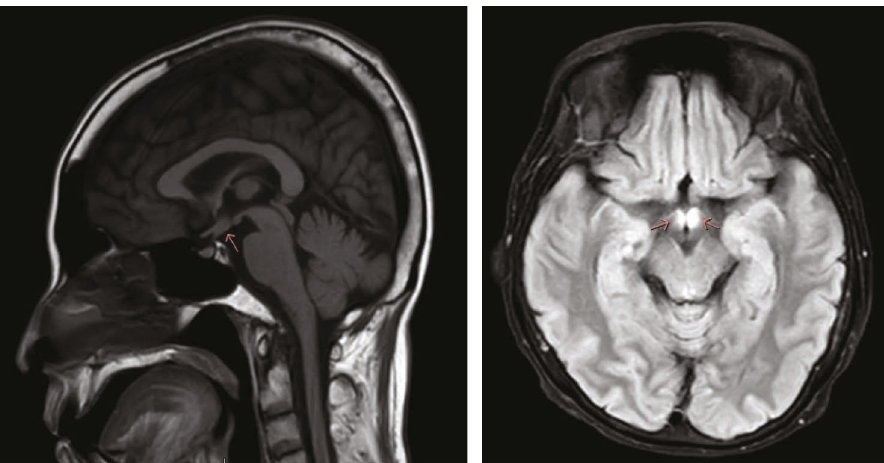
Figure 1: T1 and T2 FLAIR sections of magnetic resonance imaging show hyper signal intensity involving the bilateral hypothalamus.